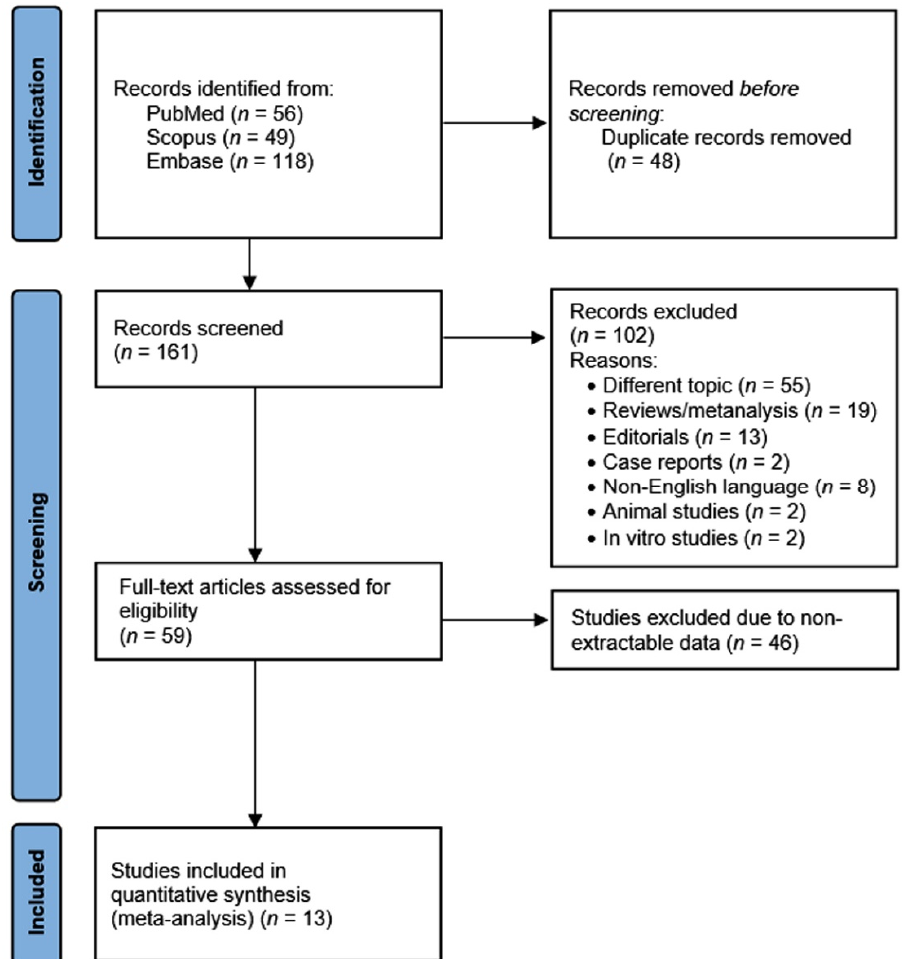
Figure 1. Preferred Reporting Items for Systematic Review and Meta-Analysis Protocols (PRISMA-P) flowchart.